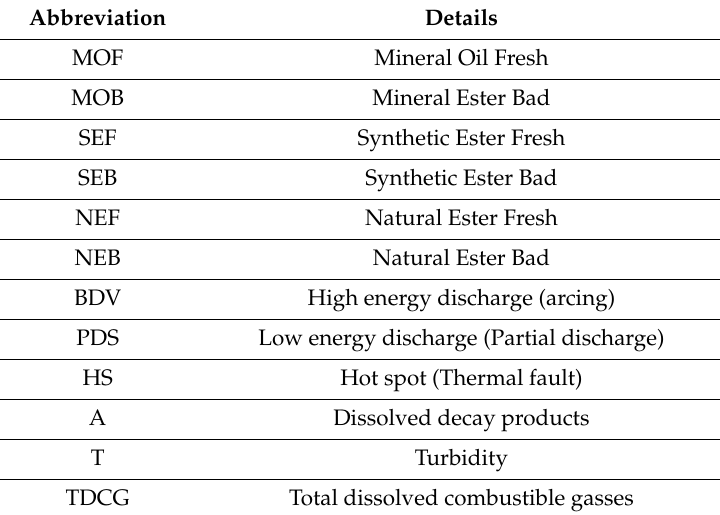
Table 4. List of